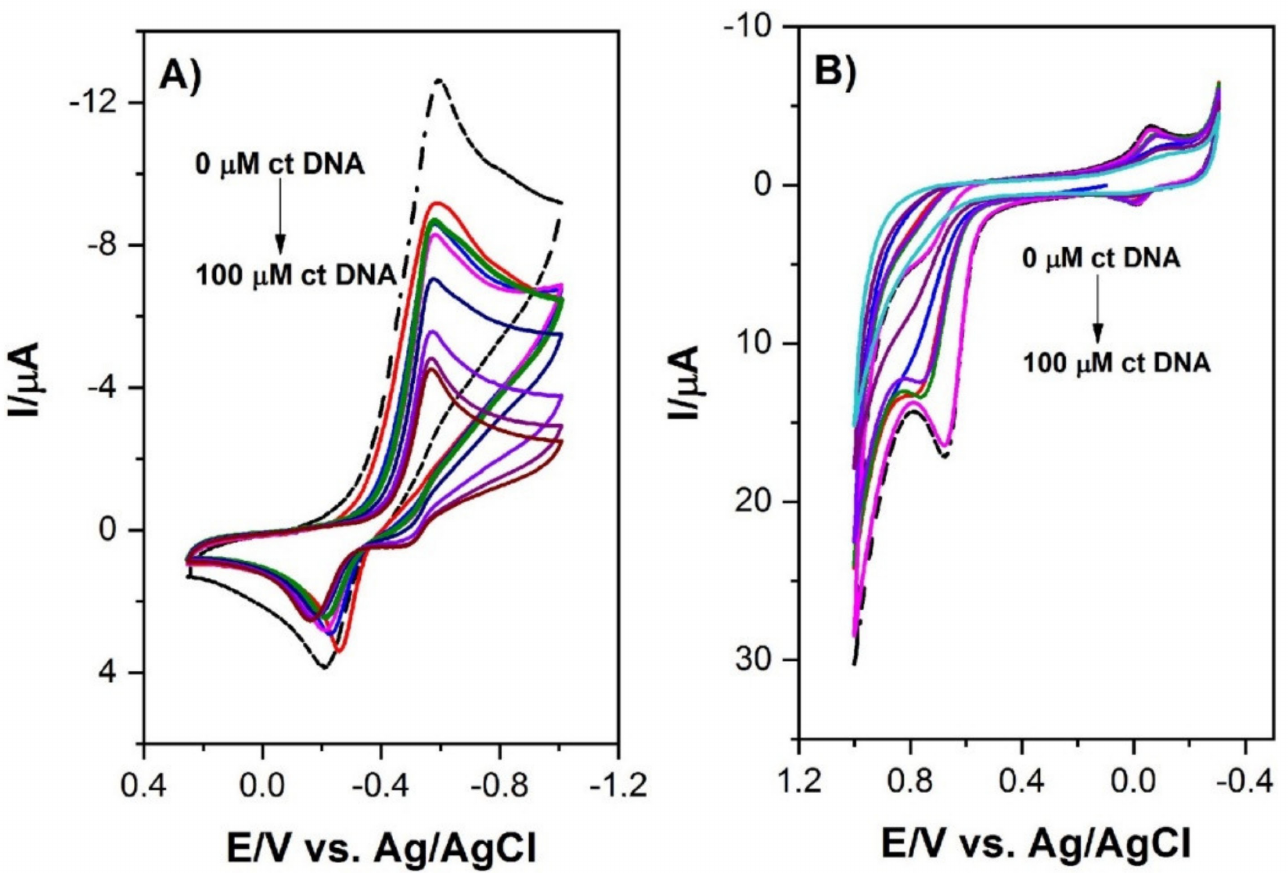
Figure 2. ( A ) Cyclic voltammogram of 2 × 10 − 4 M 1,5-ppz-AQ in an aqueous buffer at pH 7.4 in the absence (dashed line) and the presence (solid line) of 10–100 µ M ct-DNA on the glassy carbon electrode. Scan rate: 100 mV s − 1, temperature: 25 ◦ C; ( B ) Cyclic voltammogram of 2 × 10 − 4 M ethidium bromide in aqueous buffer at pH 7.4 in the absence (dashed line) and the presence (solid line) of 10–100 µ M ctDNA on the glassy carbon electrode. Scan rate: 100 mV s − 1, temperature: 25 ◦ C. Figure adapted from the reference [24] with permission from